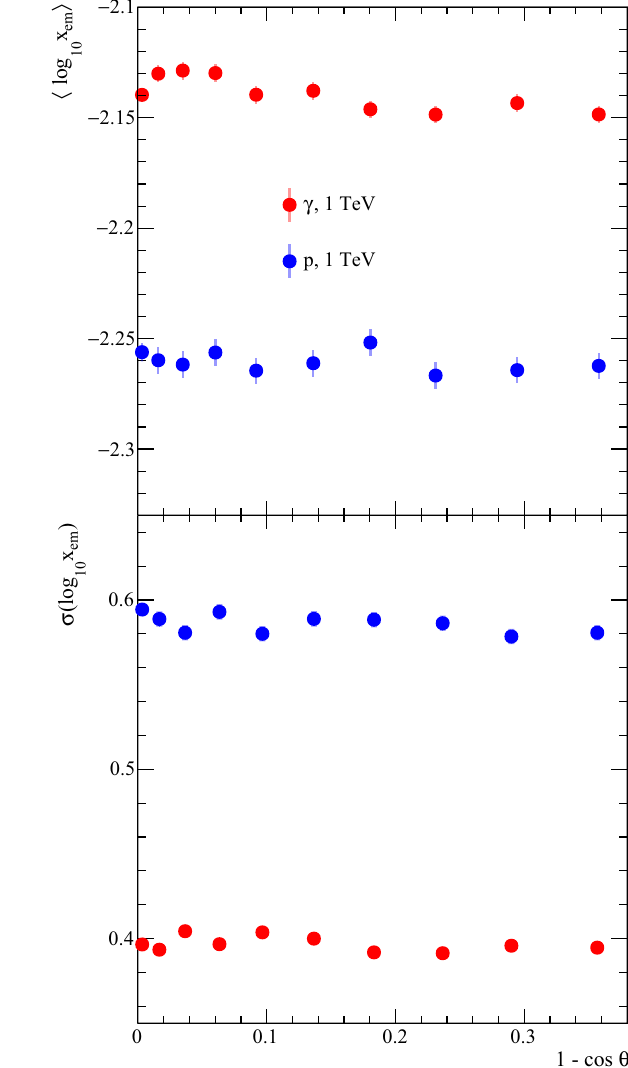
Fig. 12 The dependence of the fractional electromagnetic energy arriving at ground x em = E em / E p on zenith angle ( θ ), for primary protons and γ rays of 1 TeV. The top panel shows the dependence of the mean of the log 10 ( x em ) distribution, while the bottom panel shows the behaviour of the rms ( σ ) of the same distribution. Each data point corresponds to a slant depth of 800 g cm − 2 and a combination of zenith angle and ground-level from Fig. 14, ground altitudes are between 2.1 and5.6kmandthezenithanglerangeisfrom0 ◦ and55 ◦ .Errorbarsindi- cating the statistical uncertainty are typically of the size of the marker or